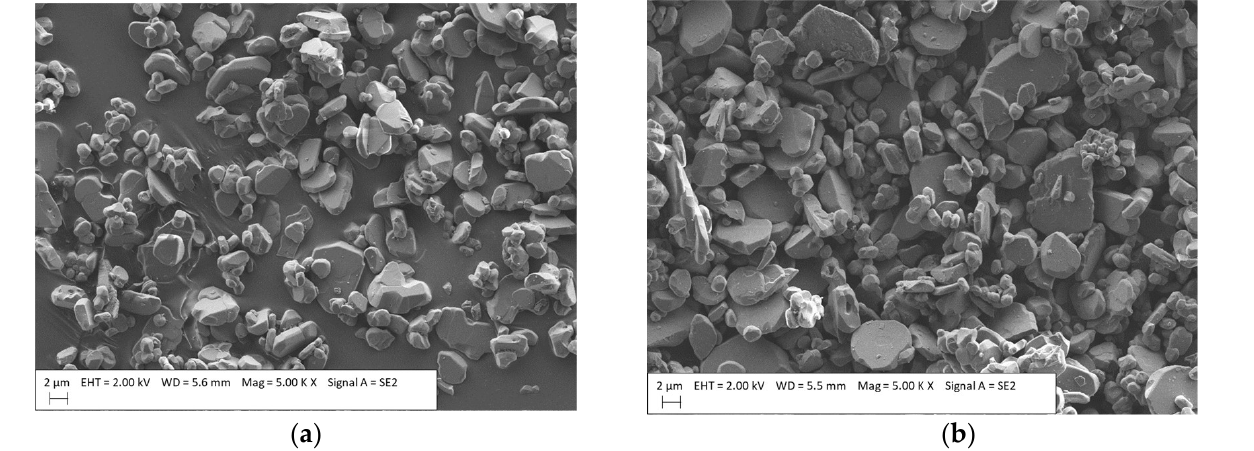
Figure 13. SEM images of the alumina powders: ( a ) collected from the anode support after Experi- ment II; ( b ) milled HVA powder used to conduct Experiment II.